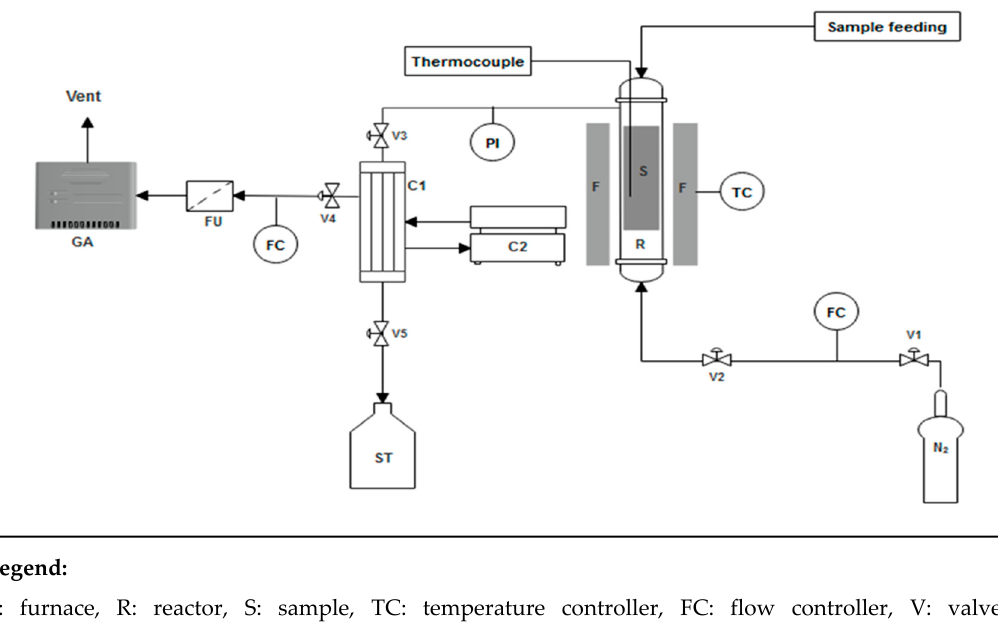
Figure 1. Schematic diagram of experimental setup for pyrolysis of plastic mixtures.